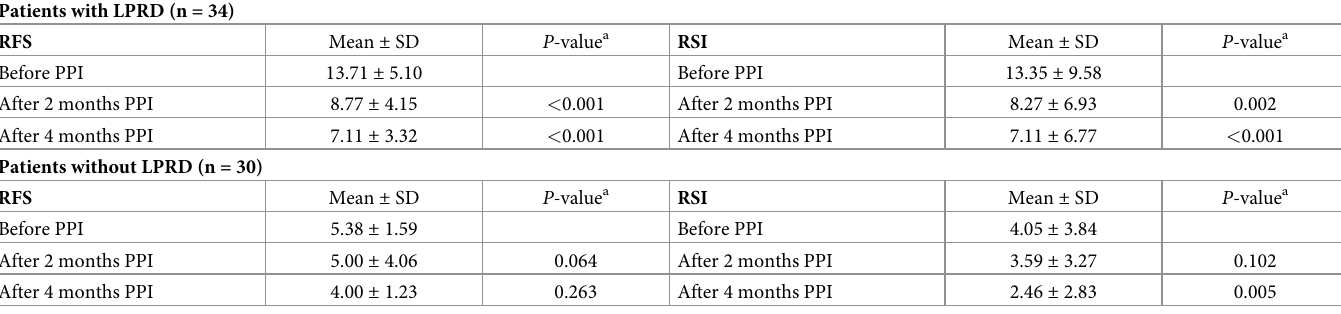
Table 4. Changes in the Reflux Finding Score (RFS) and Reflux Symptom Index (RSI) before and after the administration of a Proton Pump Inhibitor (PPI) (n = 64) according to the presence of Laryngopharyngeal Reflux Disease (LPRD). Patients with LPRD (n = 34)